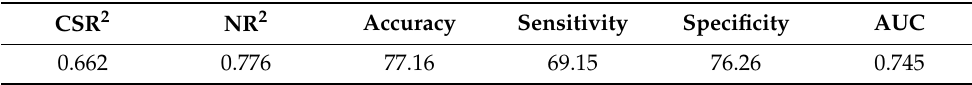
Table 3. Statistics indexes and AUC value of the LR model.